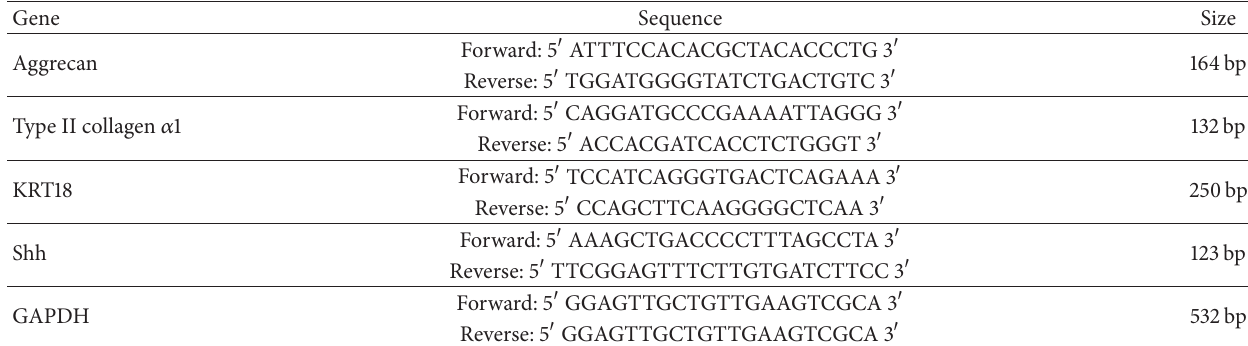
Table 1: Real-time polymerase chain reaction primers.